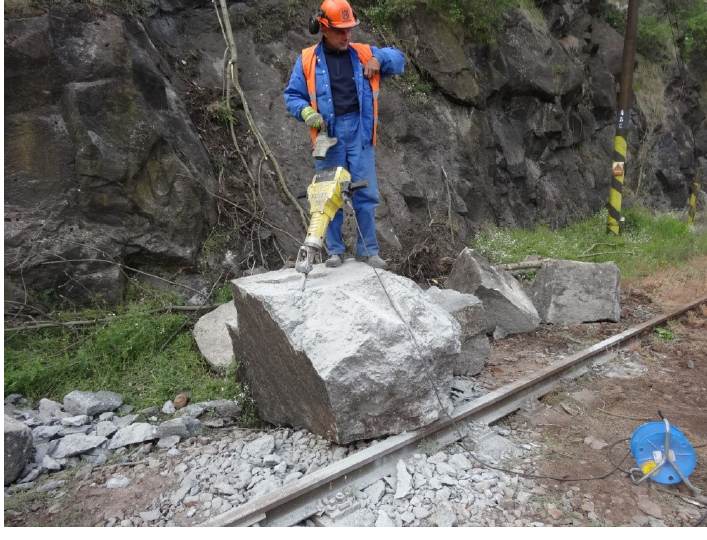
Figure 3. Fallen rock block after partial disintegration.